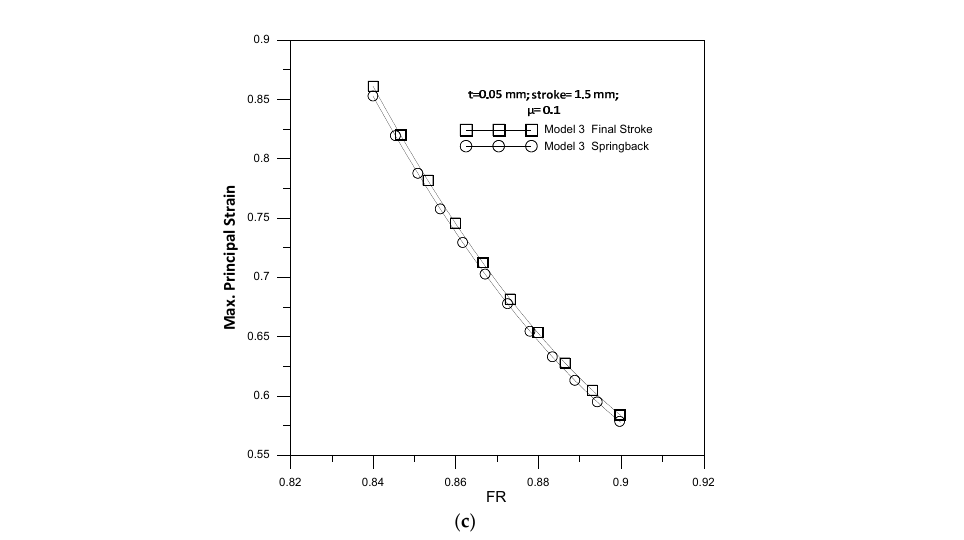
Figure 16. The relationship between the hole radius and maximum principal strain in the flange: ( a ) Model 1; ( b ) Model 2; ( c ) Model 3. 4.3.3. The Relationship between the Forming Ratio and the Maximum Height of the Flange Figure 17 shows the relationship between the forming ratio and the maximum height of the flange. As the forming ratio increases, the maximum flange height decreases by approximately 27.8, 30, and 35.2% for models 1, 2, and 3, respectively. The reason for this is that the larger the FR , the larger the hole dimension, and the smaller the amount of stretch-deformed sheet, because less of it is drawn into the lower die.